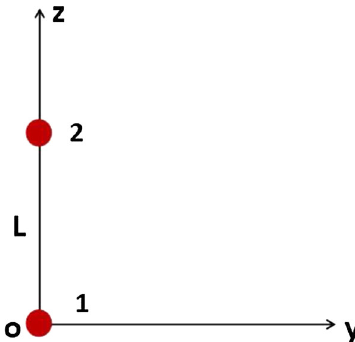
Fig. 1 Two gravitationally polarizable subsystems separated from each other by a distance of L in the z